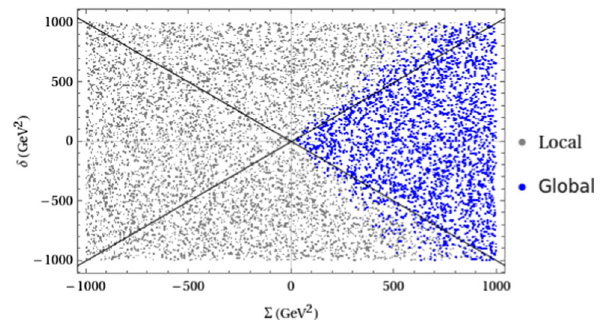
Fig. 1 The effect of the vev-preserving alignment parameters of Eq.(25)onthedepthofthechosenminimum.Theentirefour-parameter scan is projected onto the ((cid:2),δ) plane within the range − 10 3 GeV 2 ≤ (cid:2),δ ≤ 10 3 GeV 2 . Blue (gray) dots correspond to soft breaking param- eter sets leading to the global (local) minimum. The black lines are the borders where μ 2 or μ 3 changes